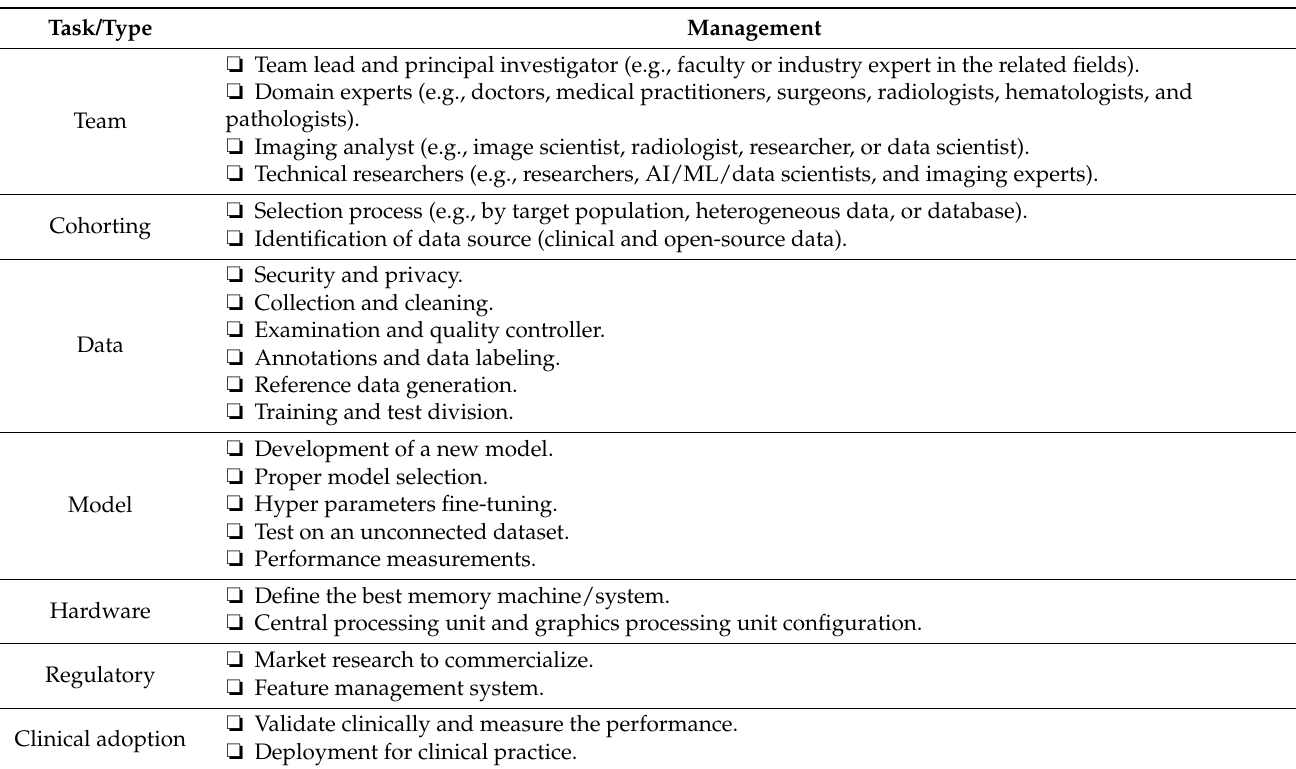
Table 6. Checklist of steps required for project management involving CV and